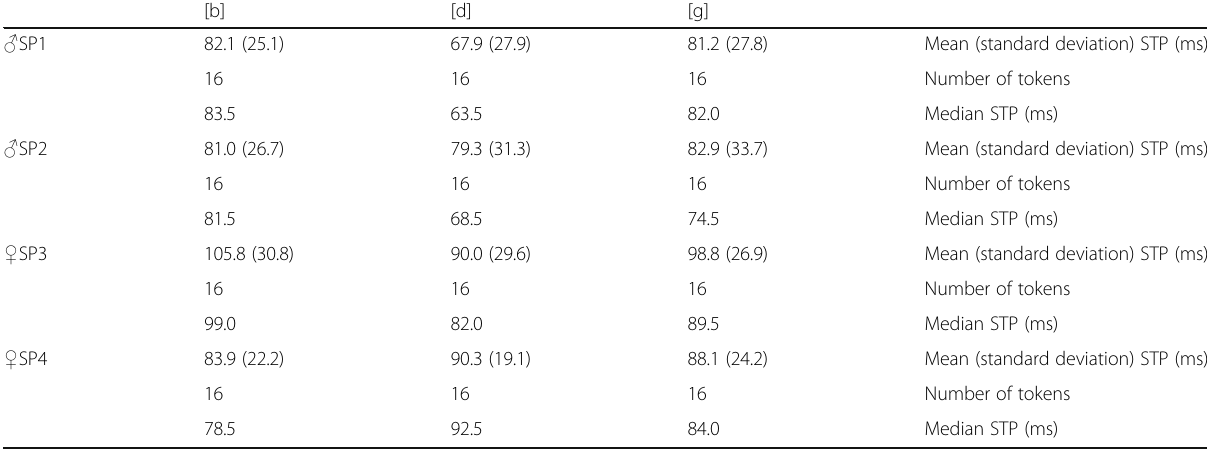
Table 6 Mean (standard deviation) STP, number of tokens and median